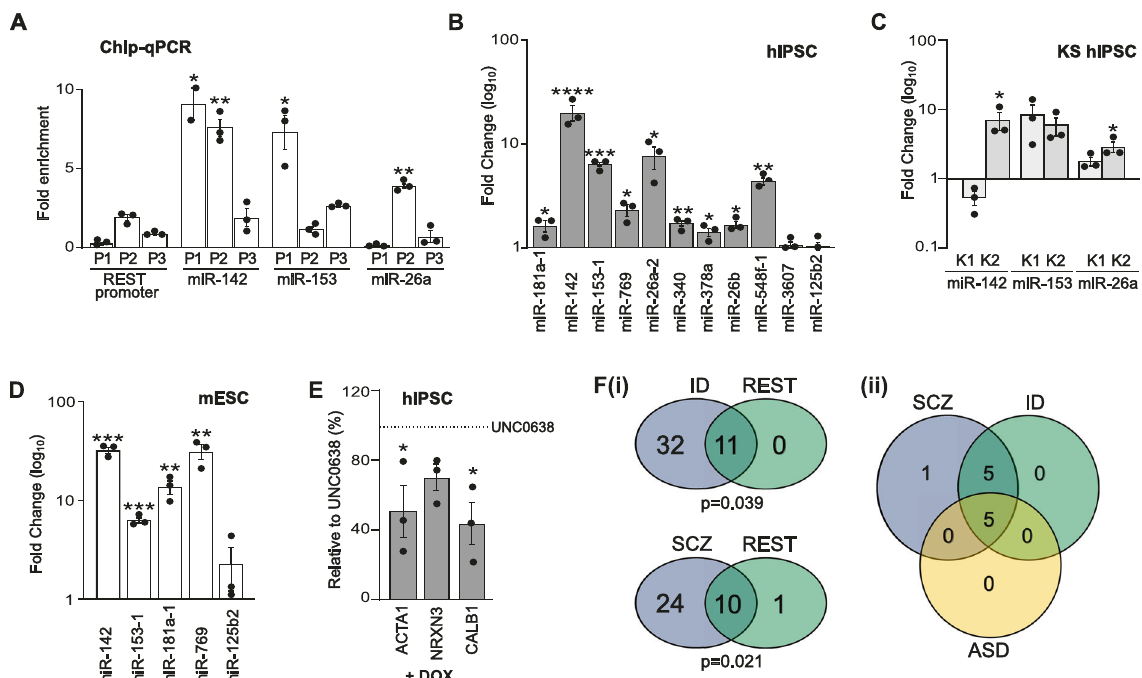
Fig. 2 EHMT1 suppresses expression of miRNA. A ChIP-qRT-PCR analysis of H3K9me2 modi fi cation within 3 regions of NRSF/REST promoter (P1, P2, P3) and surrounding (P1, P2) and distal to (P3) the Translational Start Sites (TSSs) of miR-142, miR-153 and miR-26a promoters of pluripotent hiPSC (see Fig. S3). ChIP was performed with an anti-H3K9me2 antibody, and H3K9me2 enrichments were analysed by qRT-PCR. Enrichment is plotted as increase relative to the input DNA in speci fi c genomic regions in the absence of ChIP antibody primer sets are listed in Table S4. B – D Validation of miRNA-seq data by qRT-PCR to con fi rm miRNA-seq results: ( B ) UNC0638-treated hiPSC; ( C ) KS-patient iPSC; ( D ) UNC0638-treated mECS. The qRT-PCR data were shown as Mean±SEM and analysed by One-way ANOVA with post hoc comparisons using Dunnett ’ s multiple comparisons test comparing to control samples. * P < 0.05, ** P < 0.01, *** P < 0.001, **** P < 0.0001, n ≥ 3. E Relative mRNA abundance measured by qRT-PCR of the REST-target genes ACTA1, NRXN3, and Calbindin1 (CALB1) in pluripotent hiPSCs treated with UNC0638. Induction of REST Δ UTR with doxycycline (DOX) suppresses the UNC0638-induced gene expression. Results are plotted as % of mRNA abundance in the absence of DOX, shown as dotted line. F , i Venn diagrams showing association between miRNAs following UNC0638 treatment and those associated with Intellectual Disability (ID) and schizophrenia (SCZ). Crossover probability was assessed for each disorder by calculating hypergeometric probability, with P < 0.05 considered statistically signi fi cant; ( ii ) Venn diagram to show overlap of REST targeting miRNAs between ID, SCZ and